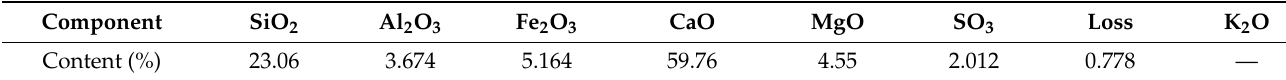
Table 2. Chemical components of low-heat cement (% by weight).